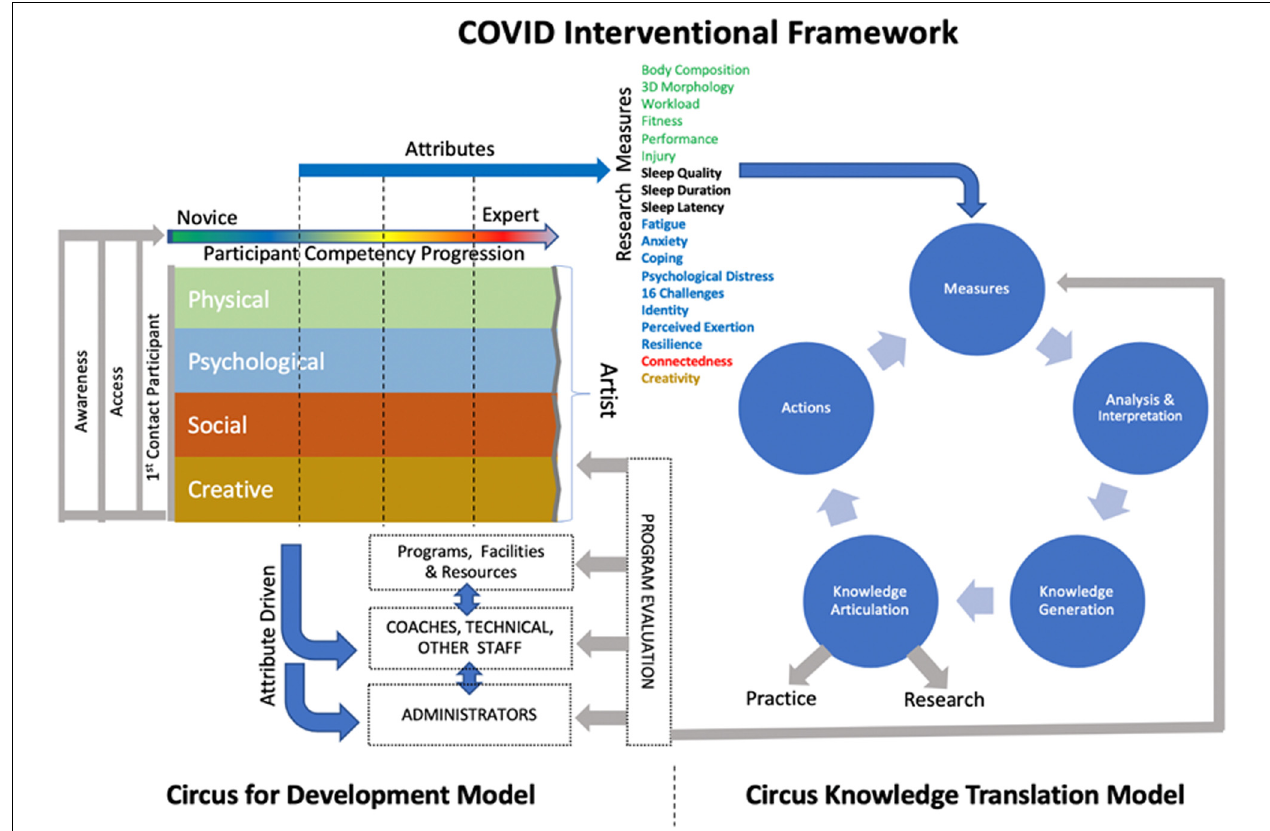
FIGURE 2 | Framework to support the holistic wellbeing of performing